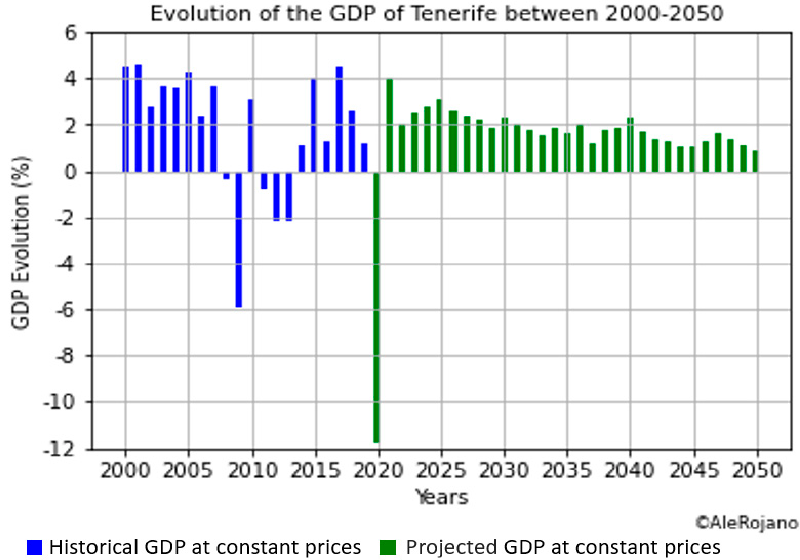
Figure 5. Evolution and projections of GDP on the island of Tenerife between 2000–2050.